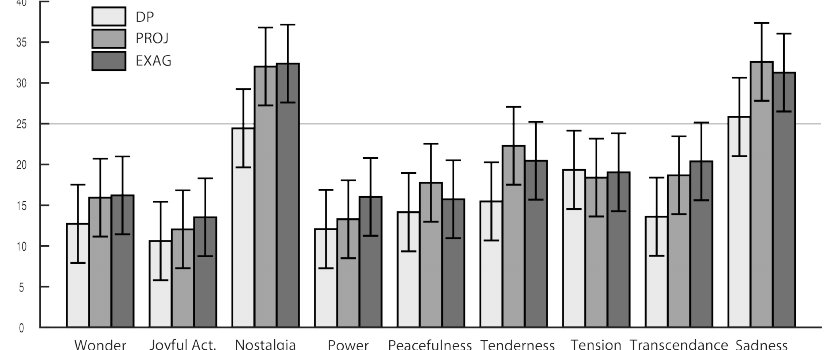
Figure A3. Impact of the interaction between the Geneva emotional scale and the expressiveness (deadpan: DP, projected: PROJ, and exaggerated: